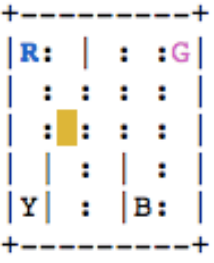
Figure 1. Taxi-v2 in OpenAI gym